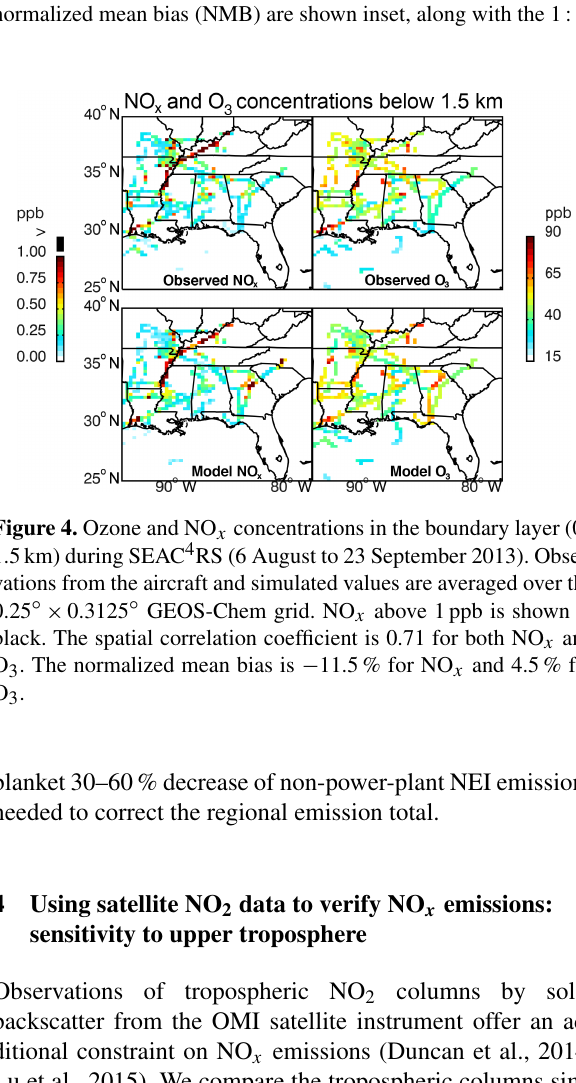
Figure 3. Nitrate wet deposition fluxes across the US in August–September 2013. Mean observations from the NADP network (circles in the left panel) are compared to model values with decreased NO x emissions (background). Also shown is a scatterplot of simulated vs. observed values at individual sites for the whole contiguous US (black) and for the Southeast US (green). The correlation coefficient ( r ) and normalized mean bias (NMB) are shown inset, along with the 1:1 line.